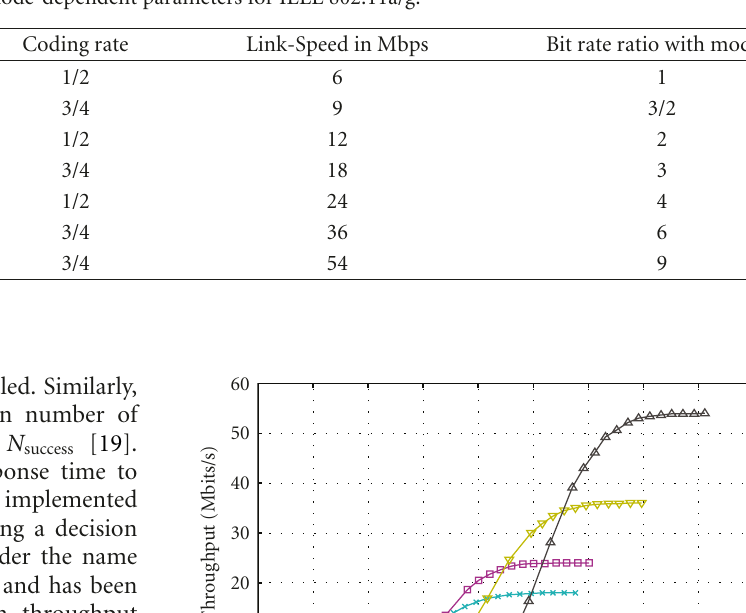
Table 1: Mode-dependent parameters for IEEE 802.11a/g.